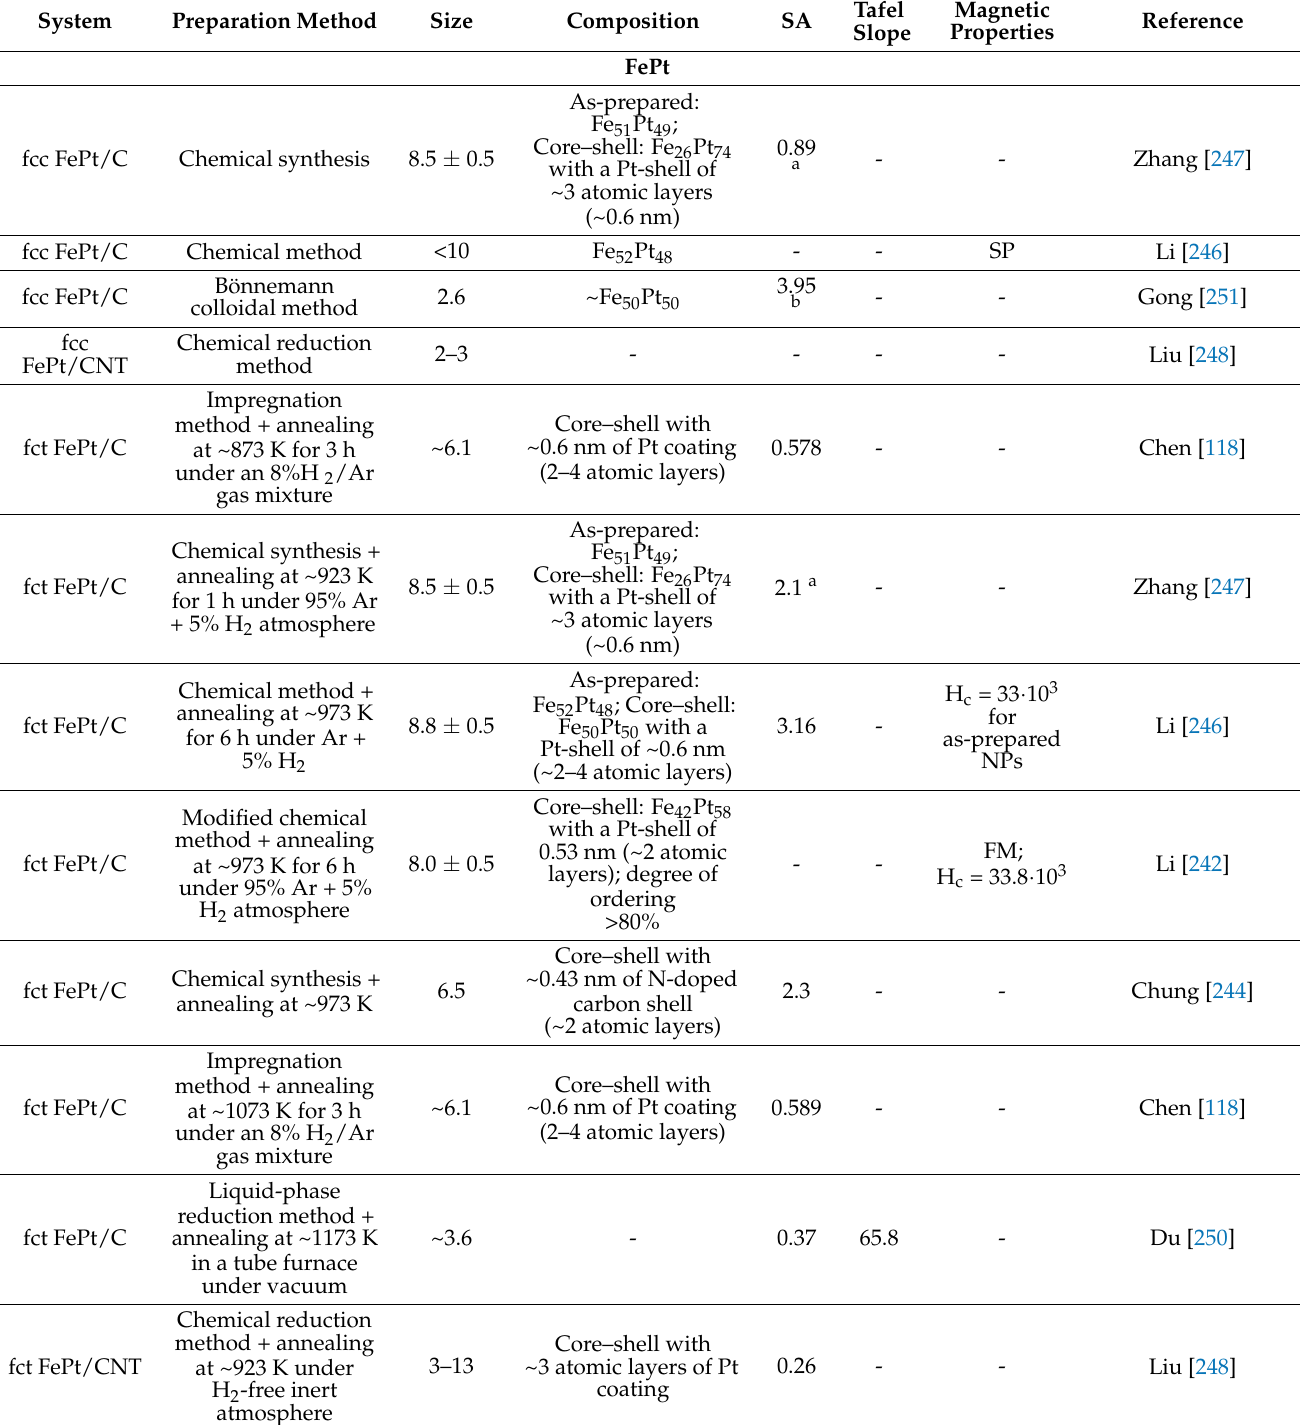
Table 5. Experimental preparation methods, size, composition, catalytic performance and magnetic properties of some MPt nanoparticles (M = Fe, Co, Ni) employed as ORR catalysts and reported also in Table 3. The size of the NPs is reported in nm. Catalytic performances are represented by the specific activity (SA, mA · cm − 2 ) and the Tafel slope (mV · dec − 1 ) measured in a 0.1 M HClO 4 solution at r.t. and at 0.9 V vs. RHE (unless otherwise specified). Magnetic properties are indicated in the centimeter/gram/second system (CGS) and include magnetic state (FM = ferromagnetic, SP = superparamagnetic) and coercivity (H c , Oe) recorded at room temperature. Magnetic